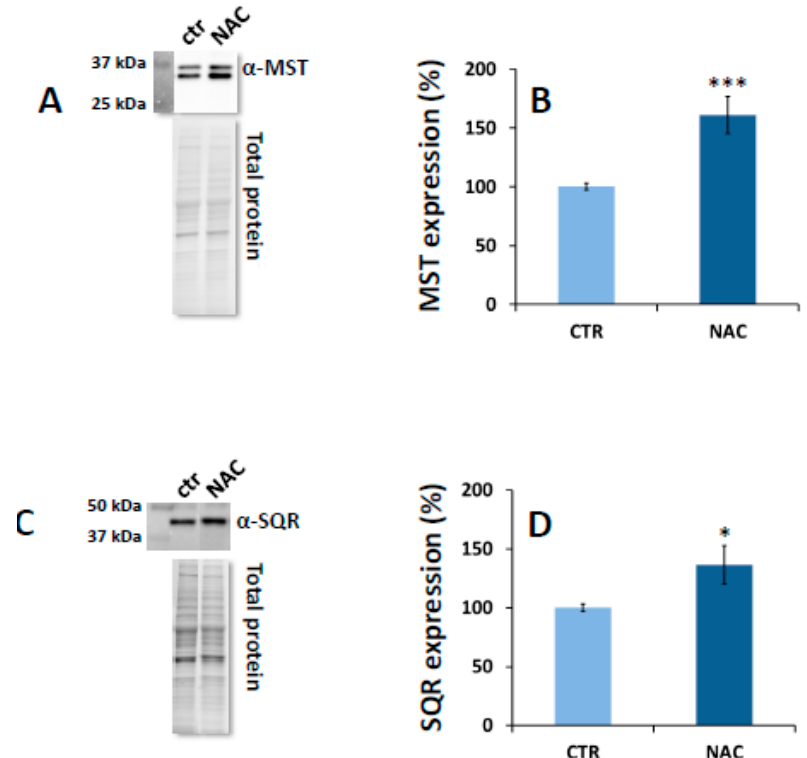
Figure 1. E ff ect of NAC on MST and SQR expression. (Panel A ) Representative Western blot analysis of MST expression in SW480 cells grown for 24 h in DMEM alone (control) or supplemented with 10 mM NAC (NAC). The blots are shown together with their corresponding total protein load quantitation by stain-free imaging technology (see Materials and Methods). (Panel B ) MST expression levels as normalized to total protein. Data represent the mean value ± SEM of 6 repeats, each carried out in technical duplicate. *** p ≤ 0.001. (Panel C ) Similarly to panel A, representative Western blot analysis of SQR expression. (Panel D ) SQR expression levels as normalized to total protein. Data represent the mean value ± SEM of 5 repeats, each carried out in technical duplicate. * p ≤ 0.05.